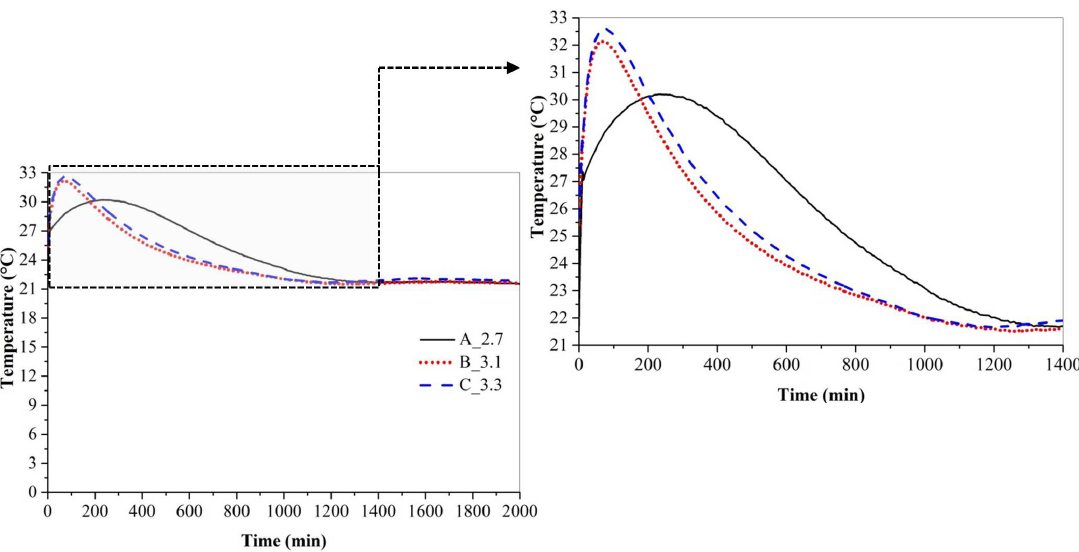
Figure 8. Heat evolution curves of the mortars made with the one-part AAB immediately after water addition (a) with magnification from 21 °C to 33 °C (b) (average ambient temperature during the test = 20.9 °C ± 2 °C).